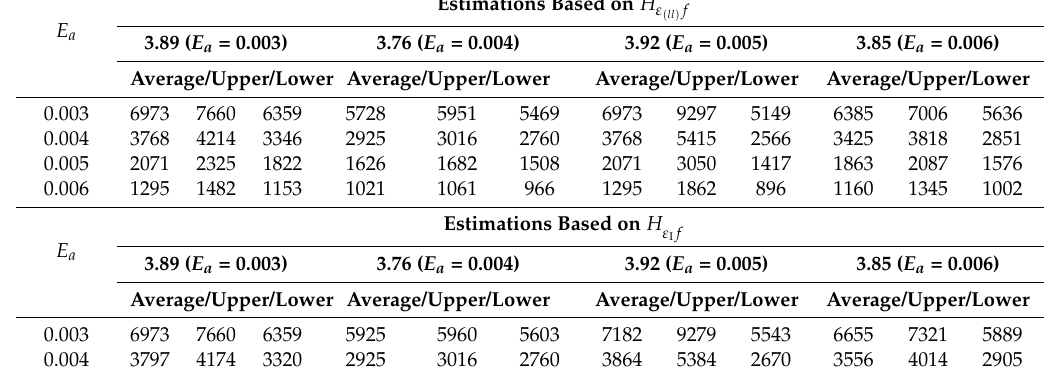
Table 8. Prediction of low-cycle lives of the pure copper T2 by applying H ε E a